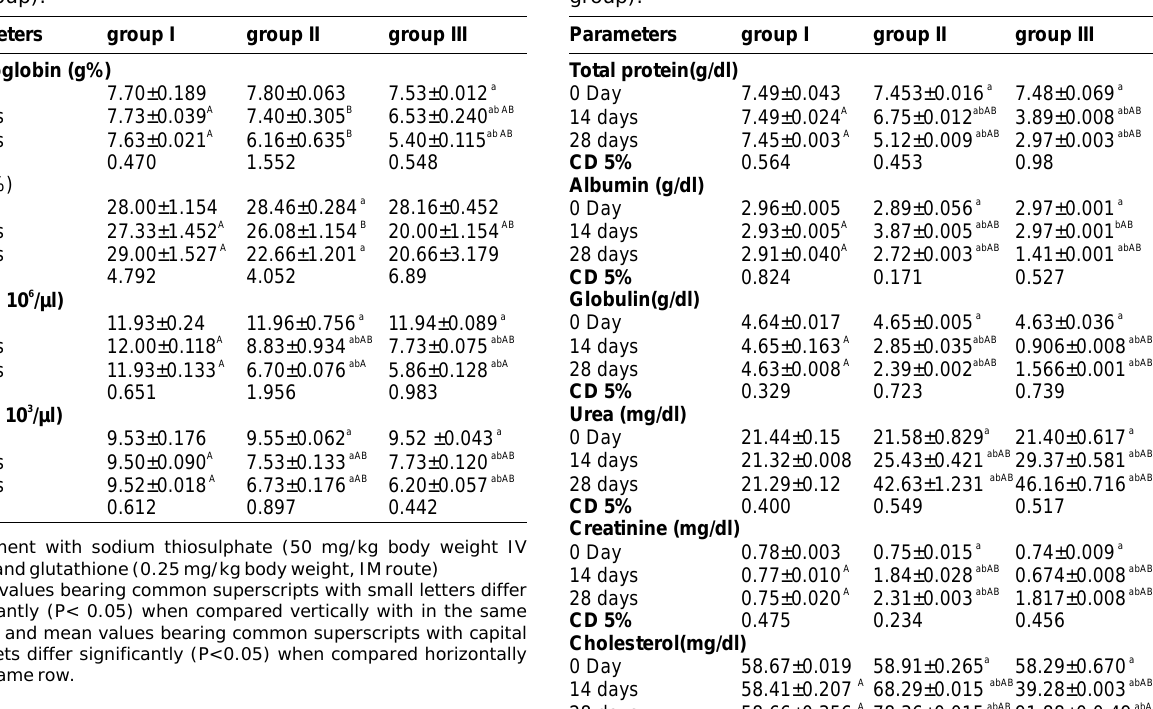
Table-2. Effect on haematological parameters following daily oral administration of Jatropha seed oil with our without treatment for 28 days in goats (mean ± S.E., N=3 per group).